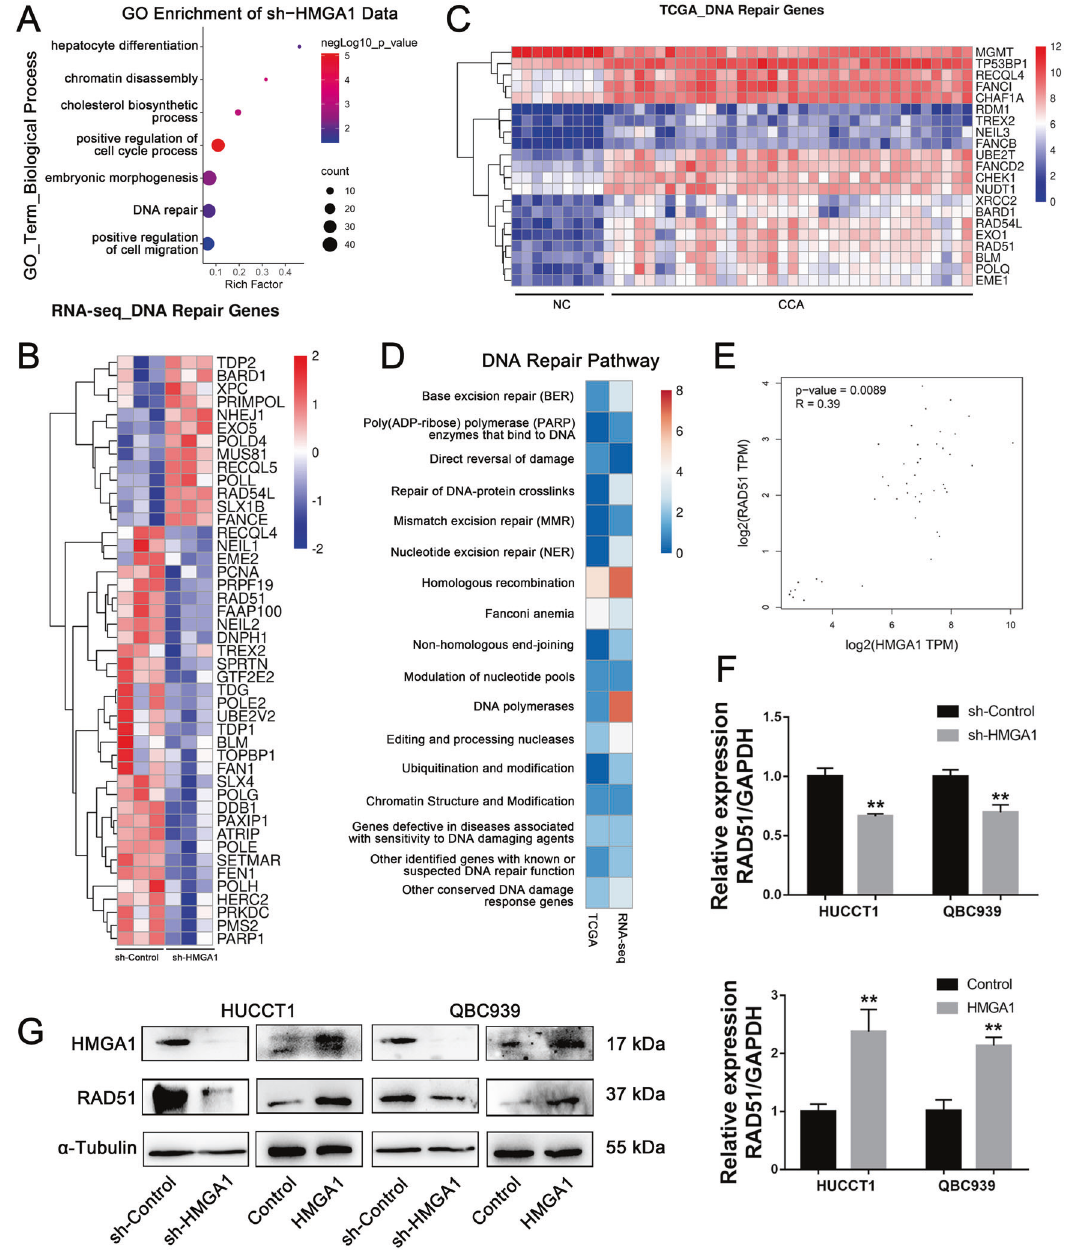
Fig. 4 HMGA1 positively regulates RAD51 expression in CCA cells. A Gene Ontology (GO) analysis of differentially expressed genes (2473 up- and 2058 downregulated) in RNA-seq data of HUCCT1 cells with HMGA1 knockdown. B , C Forty- fi ve and 21 differentially expressed DNA repair genes were fi ltered from RNA-seq data and TCGA data, respectively. D The homologous recombination pathway was enriched in both RNA-seq and TCGA data. E Correlation analysis of HMGA1 and RAD51 expression in TCGA-CCA samples ( R = 0.39, P = 0.0089). F Validation of the expression of RAD51 in HUCCT1 and QBC939 cell lines with HMGA1 overexpression and knockdown by qPCR. G The protein levels of RAD51 and HMGA1 were measured by western blot in HUCCT1 and QBC939 cells with HMGA1 overexpression or knockdown. The P -value was obtained by Student ’ s t test. The results represent the mean ± S.D. of three independent experiments. * P < 0.05, ** P < 0.01, *** P <